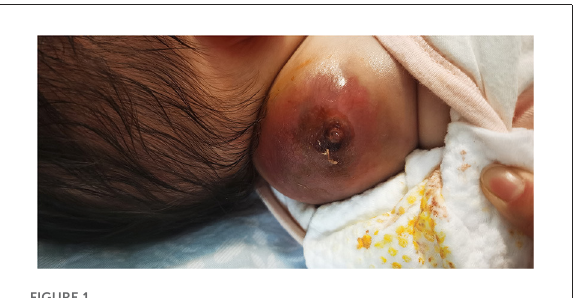
FIGURE1 Tumor 10 days after bleomycin injection.